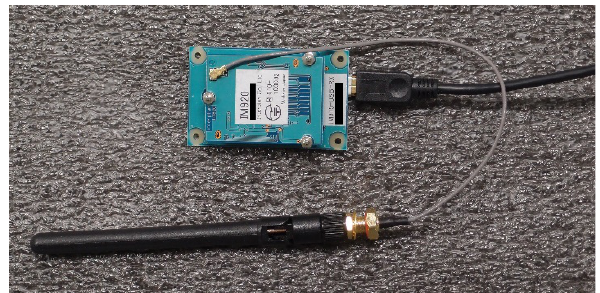
Figure 6. IM920 used in